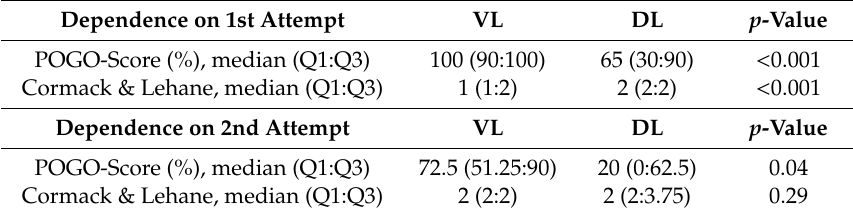
Table 5. Visibility of glottic opening in the first and second attempt for VL and